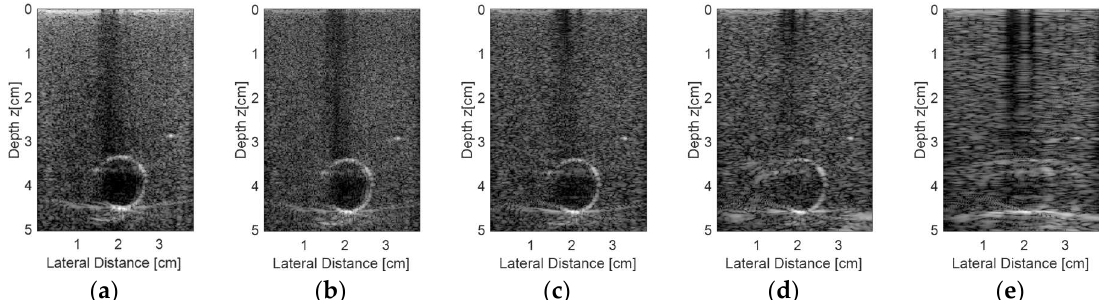
Figure 15. Images obtained from an encapsulated cyst of the commercial phantom with the transducer elements being excited with plane waves and angles in the range of −0.250° to +0.250°, 0.125° step. An average of 10 frames for each step were done for the processed images by ( a ) the Verasonics platform (using proprietary VDAS method), ( b ) using the Stolt migration method for all 128 elements and using the sparse array condition with ( c ) 65 active elements, ( d ) 44 active elements, and ( e ) 23 active elements.